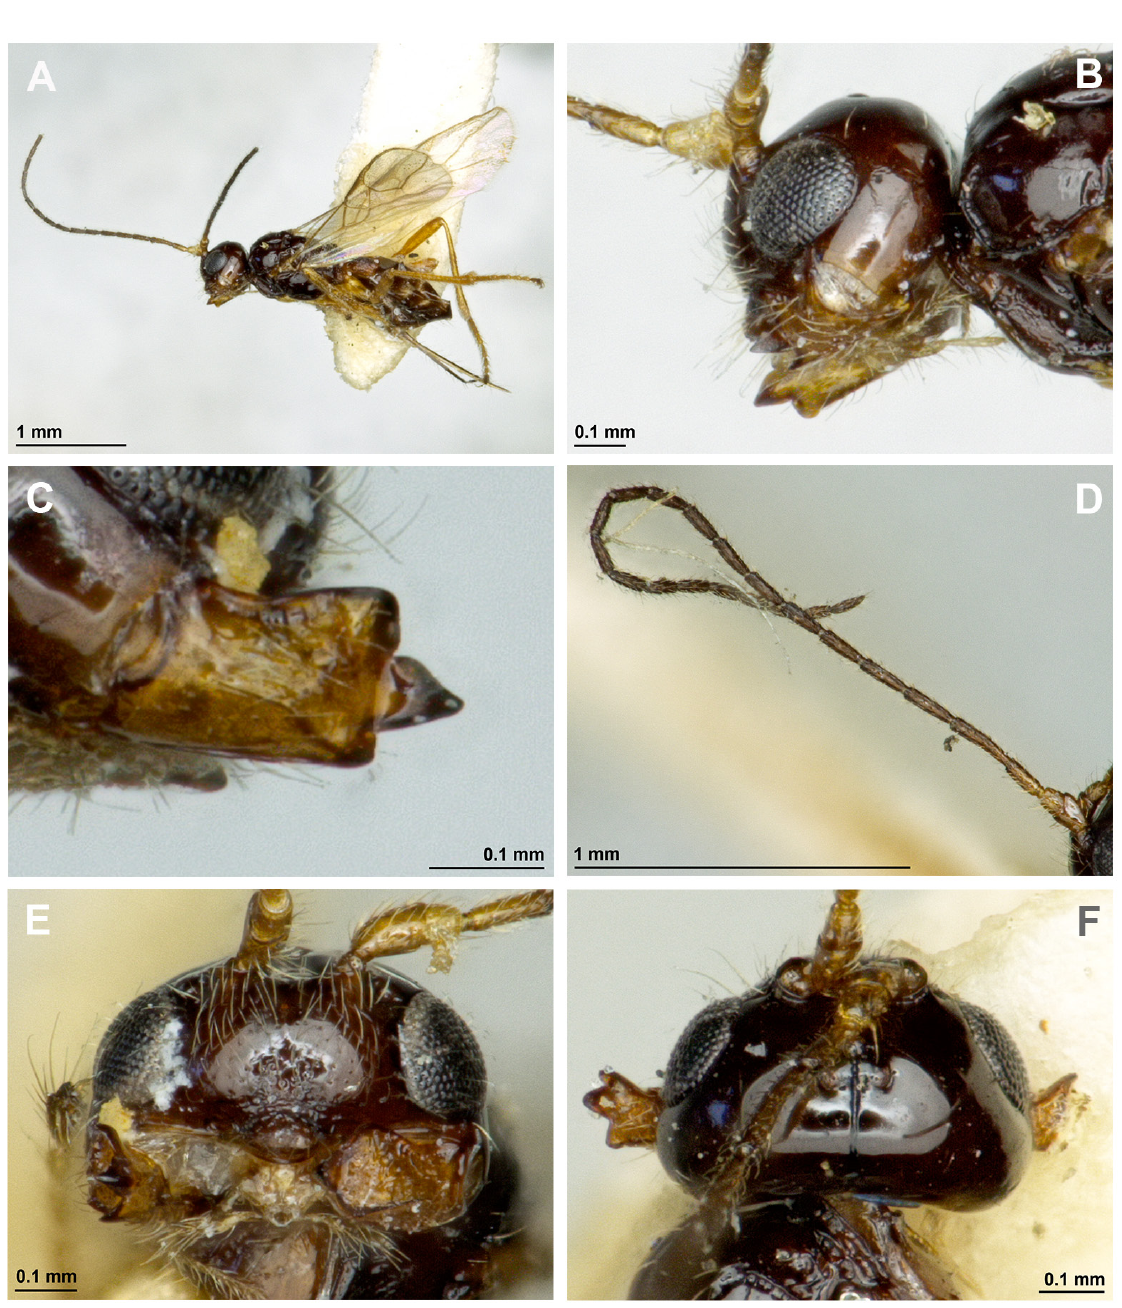
Fig. 43. Asobara natalensis Peris-Felipo, sp. nov., ♀, holotype (BMNH 1927-25). A . Habitus, lateral view. B . Head, lateral view. C . Mandible. D . Antenna. E . Head, front view. F . Head, dorsal